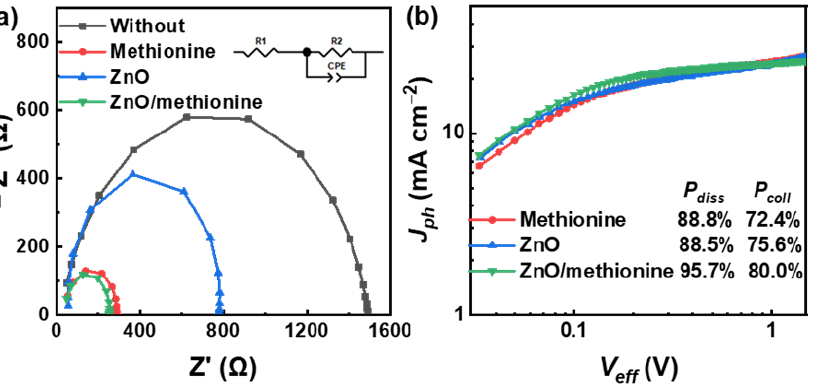
Figure 7. ( a ) Nyquist plots of the OSCs without ETL, with methionine, ZnO, or ZnO/methionine as 281 ETLs. (b) J ph – V eff curves of OSCs with methionine, ZnO, or ZnO/methionine as ETLs.